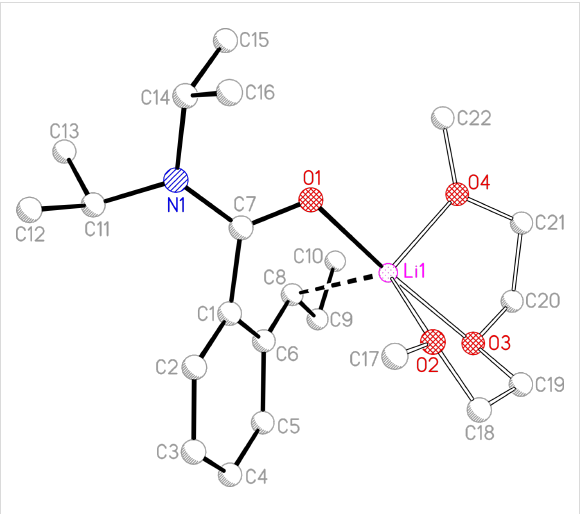
Figure 2: Molecular structure of 6 -Li l ·DGME; H-atoms omitted. Selected bond lengths (Å) and angles (°): O1–Li1 2.001(6),